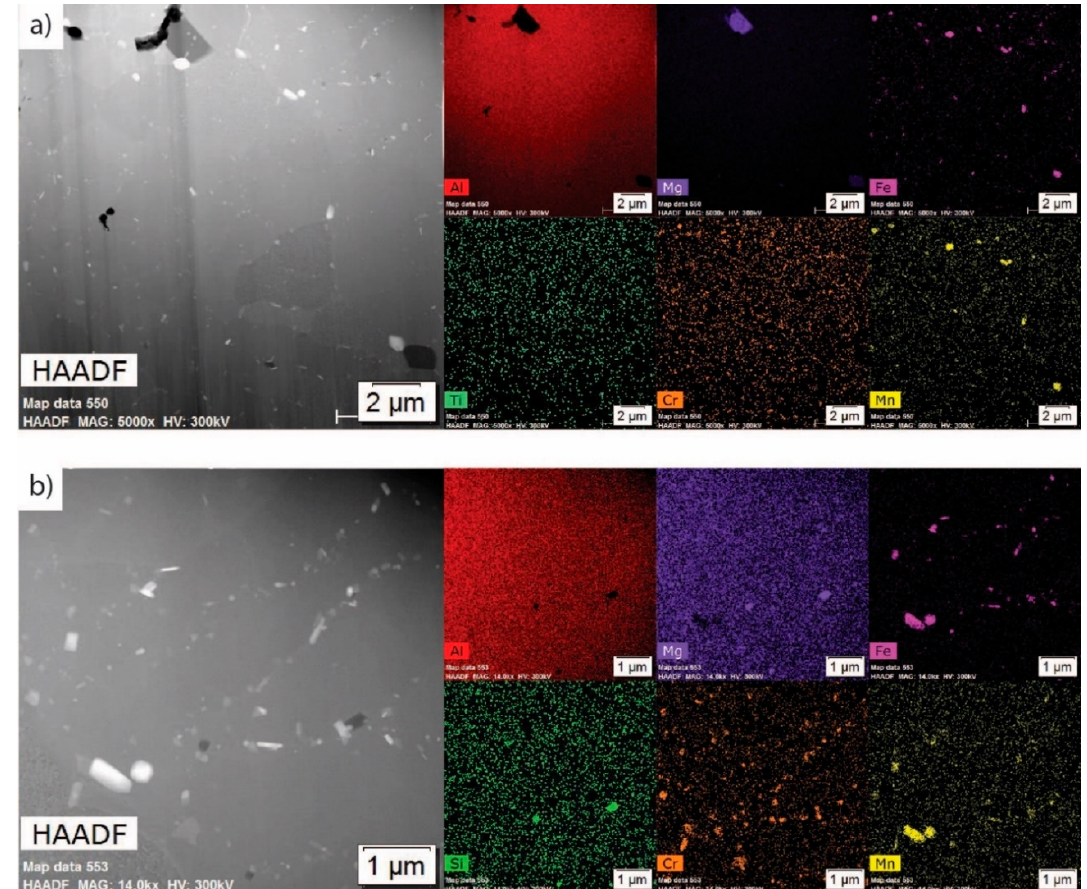
Figure 5. TEM micrographs and corresponding EDS maps of the thermally treated condition for ( a ) low magnification and ( b ) high magnification.